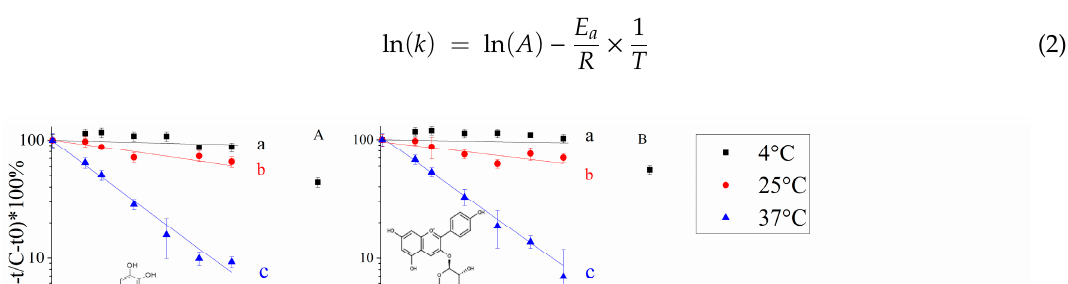
* Values with different letters indicate significant ( p < 0.05) differences. Small letters represent differences in rows (effect of temperature for the same compound) and capital letters for columns (differences between structurally different anthocyanins). * Significant increase in degradation rates of 5-pyranopelatgonidin-3- O -glucoside was observed only between 37 °C to 4 °C and 25 °C, thus E a is calculated but is more prone to errors.